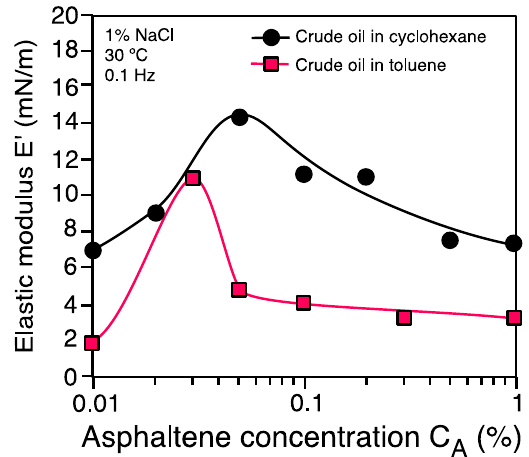
Figure 11. Elastic modulus E’ variation as a function of asphaltene concentration (C A ) in a heavy crude oil/solvent (cyclohexane or toluene)/brine (1% NaCl) system. T = 30 ◦ C. Frequency = 0.1 crude oil/solvent (cyclohexane or toluene)/brine (1% NaCl) system. T = 30 °C. Frequency = 0.1 Hz.